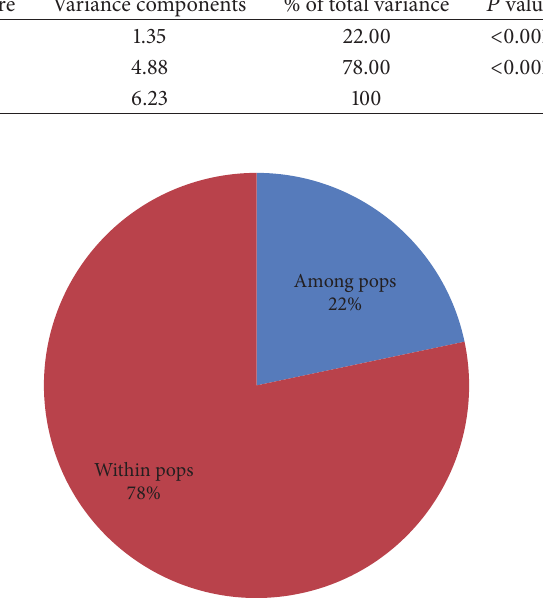
Table 3: Analysis of molecular variance (AMOVA) for five ISSR markers among M. baccifera populations. Source of variations Degree of freedom Sum of squares Mean square Variance components